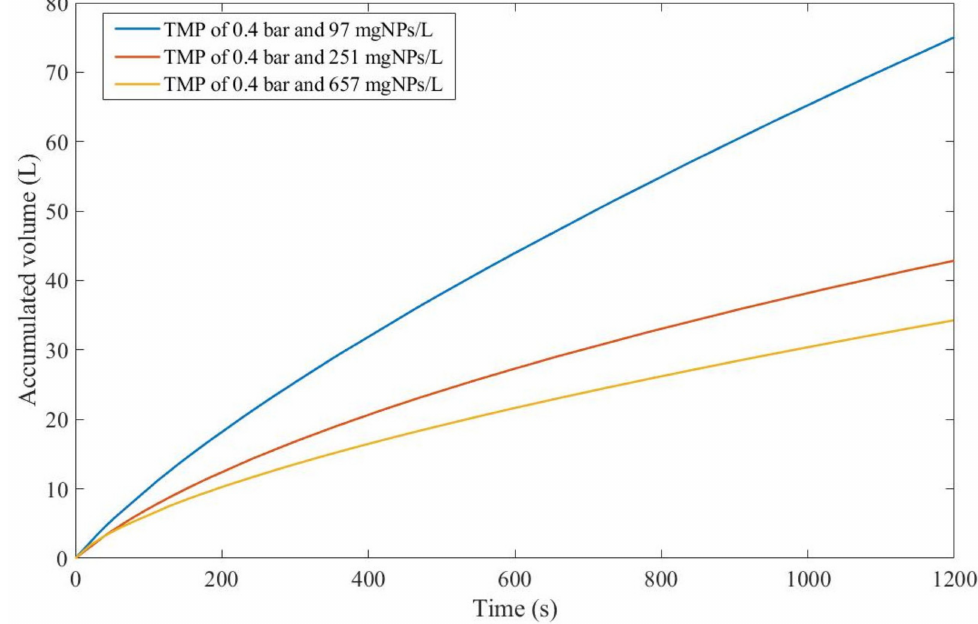
Figure 5. The accumulated volume calculated through the EHM for dead-end ultrafiltration of nanoparticles from polishing wastewater at 0.4 bar, assuming A = 1.00 m 2